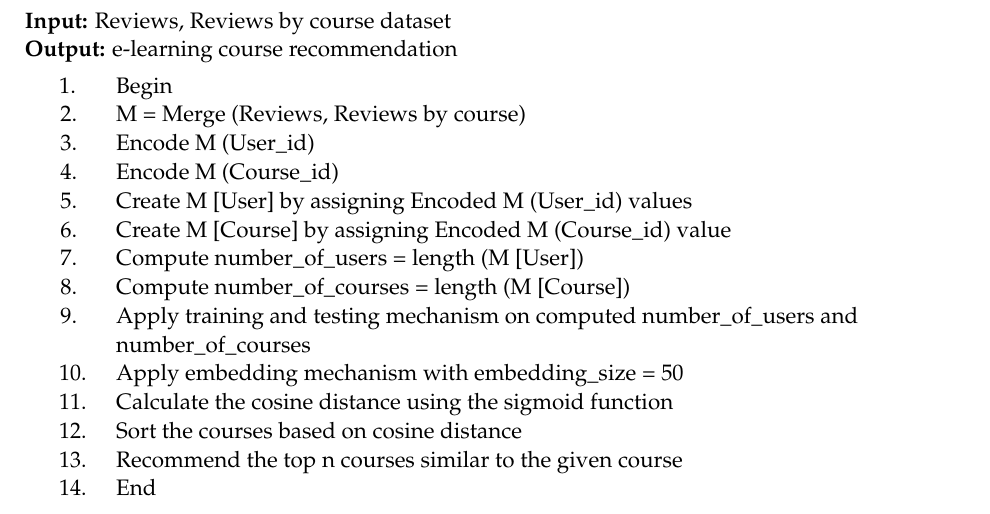
Algorithm 3: NCF for e-learning course